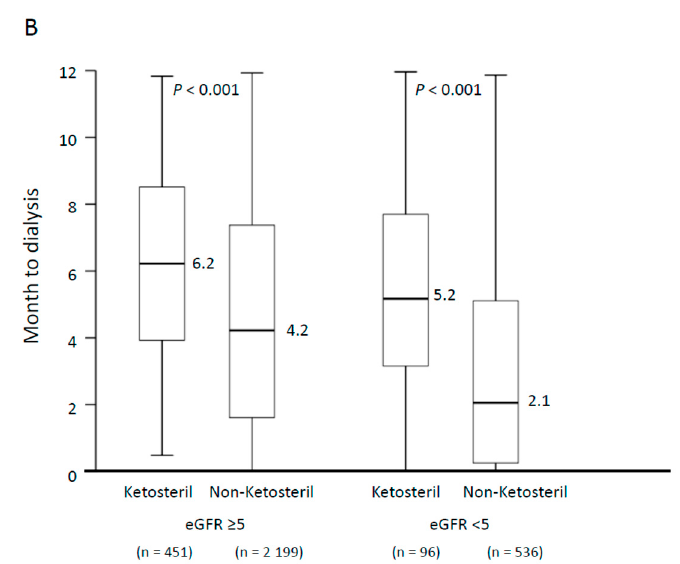
Figure 4. Median duration from the index date to the day of initiating the dialysis of patients in the Ketosteril and non-Ketosteril groups in the whole study population ( A ) and stratified by baseline eGFR level ( B ). The lower whisker is the first quartile minus 1.5 times the interquartile range and the upper whisker is the third quartile plus 1.5 times the interquartile